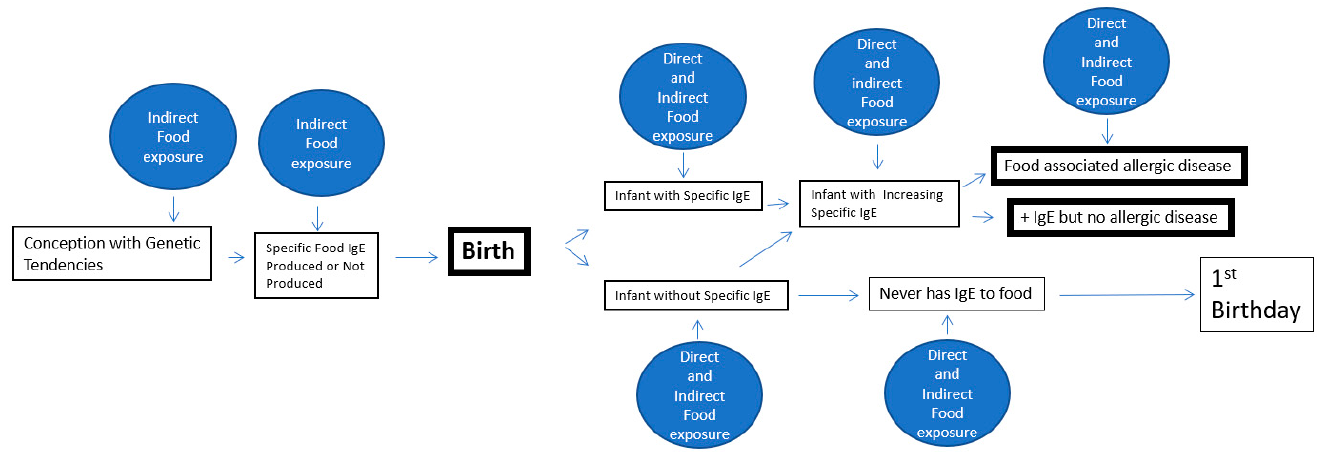
Figure 1. A schematic representation of the intrauterine chances to produce specific IgE and the subsequent events until the first birthday for clinical expression of an IgE mediated disease.